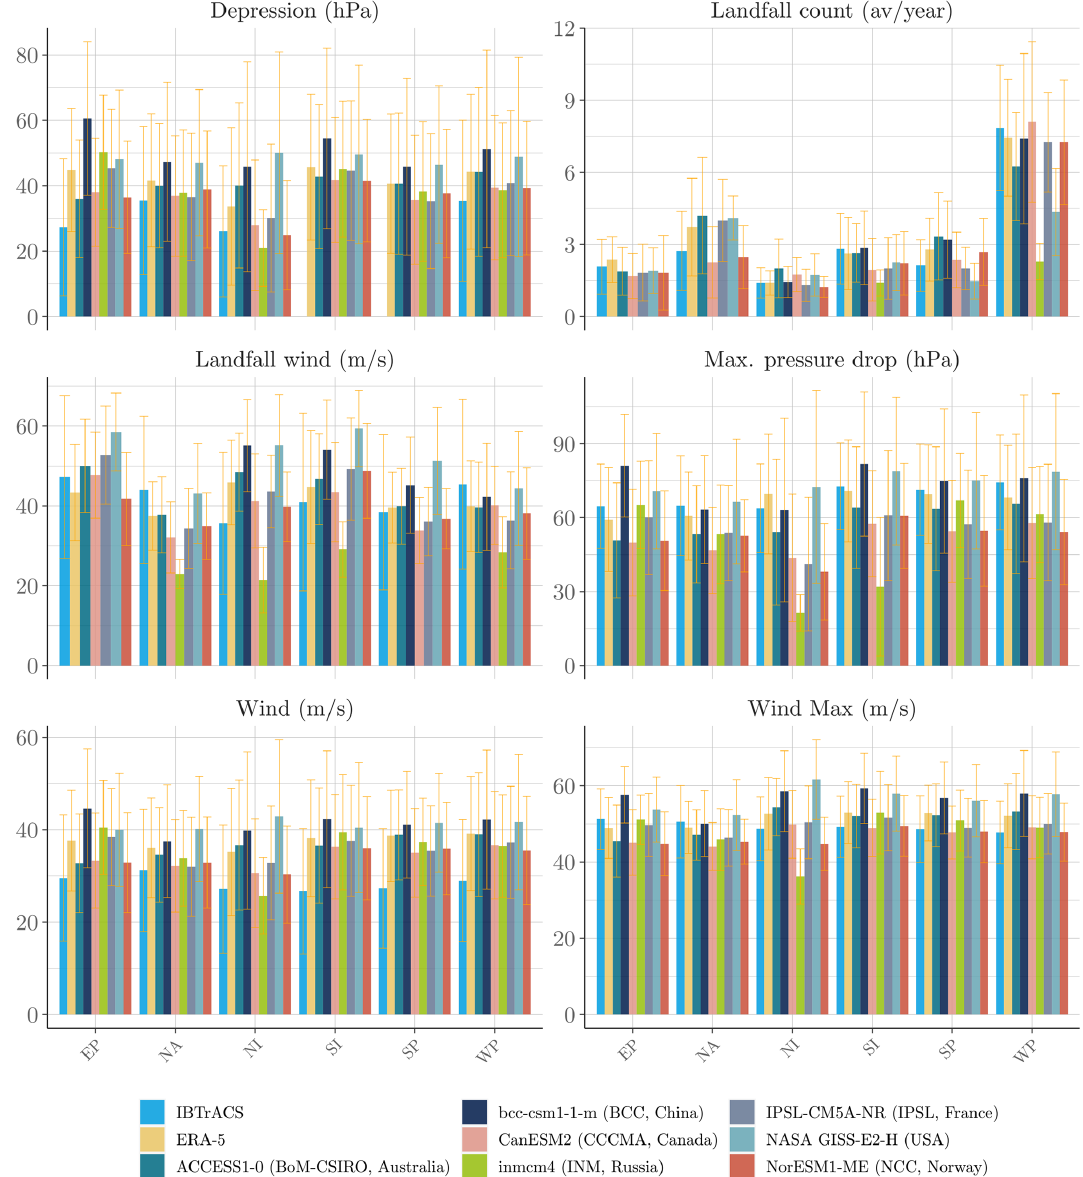
Figure A6. Evidence of model uncertainty. A comparison of the properties obtained by generating 30 years of tropical cyclones with different models from the CMIP5 raw climate data vs. ERA5. The average number of cyclones making landfall is computed by averaging the number of events with a number of steps on land positive ( s l > 0). Maximum pressure drop and wind are, respectively, computed by extracting the maximum value for the corresponding variables of the cyclone tracks. The light blue bars represent the mean of the variable of interest among the IBTrACS-filtered dataset (with the confidence interval drawn from the standard deviation of the distribution). The yellow bars represent the same variable extracted from the synthetic data generated by Algorithm 1 using ERA5 data. In terms of average values, the models produce consistent tracks in every basin. Then, we compare the output of this algorithm with different climate data produced on the historical period by the climate models taking part in the fifth phase of the CMIP. A general observation is the poorer performance of the model in the northern Indian basin. This could be due to the smaller number of intense cyclones remaining in the sample after the filtration by intensity (1.6 storms per year with winds exceeding 35ms − 1